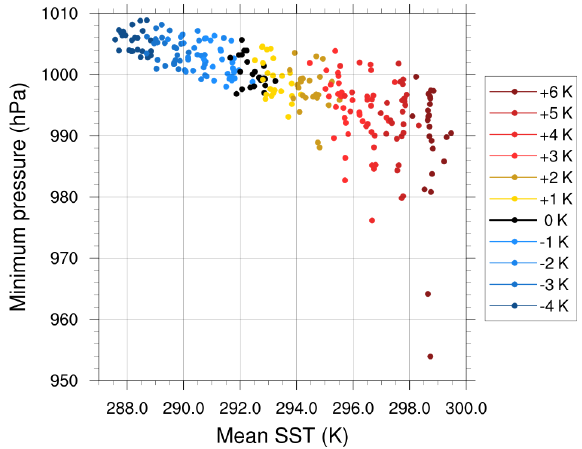
Figure 6. Dependence of minimum pressure on mean SST in a ra- dius of 150km, as encountered by the cyclone from − 20h before MWCT until MWCT. Colors represent global SST change. Note that this plot is based on all cyclones and is not a composite aver-